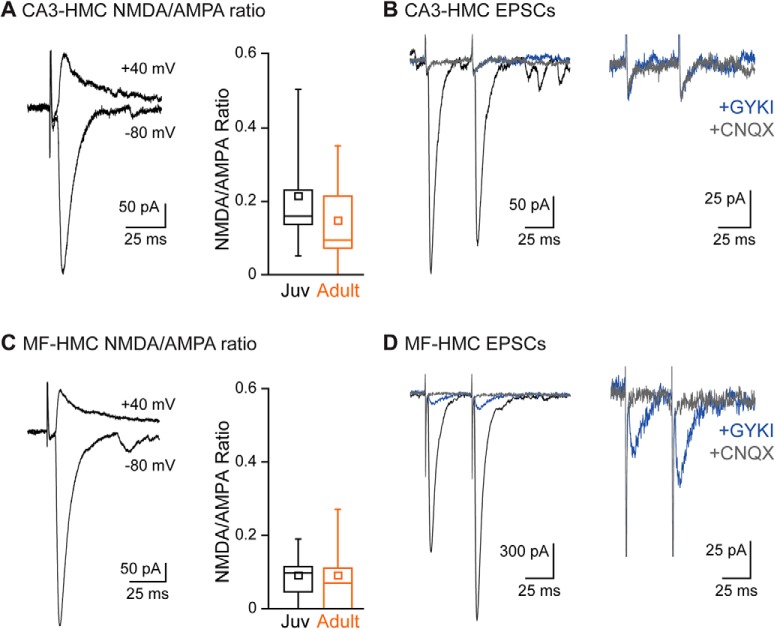
Postsynaptic receptor identity at excitatory HMC afferent synapses. A, Example EPSCs recorded from a CA3-HMC synapse while holding the HMC at -80 mV (lower trace) and +40 mV (upper trace). Population data showing NMDA/AMPA ratios at CA3-HMC synapses in juvenile (black) and adult (orange) mice. B, Example EPSCs recorded at CA3-HMC synapses (black), following addition of GYKI53655 (KAR-mediated component; blue), and following addition of CNQX (glutamate receptors blocked; gray). Expanded traces shown to the right. C, Example EPSCs recorded from a MF-HMC synapse while holding the HMC at -80 mV (lower trace) and +40 mV (upper trace). Population data showing NMDA/AMPA ratios at MF-HMC synapses in juvenile (black) and adult (orange) mice. D, Example EPSCs recorded at MF-HMC synapses (black), following addition of GYKI53655 (KAR-mediated component; blue), and following addition of CNQX (glutamate receptors blocked; gray). Expanded traces shown to the right.